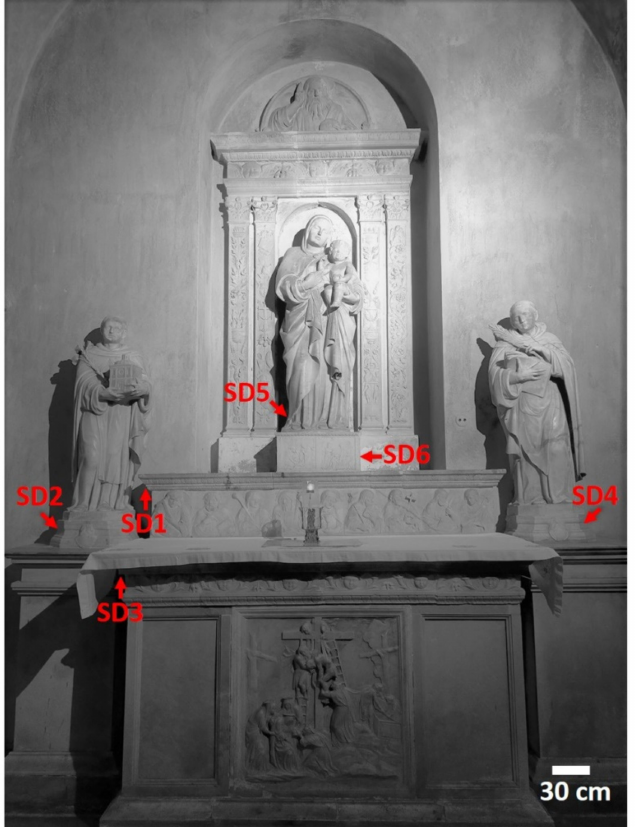
Figure 1. The marble complex “Madonna della Febbre” and details of the sample